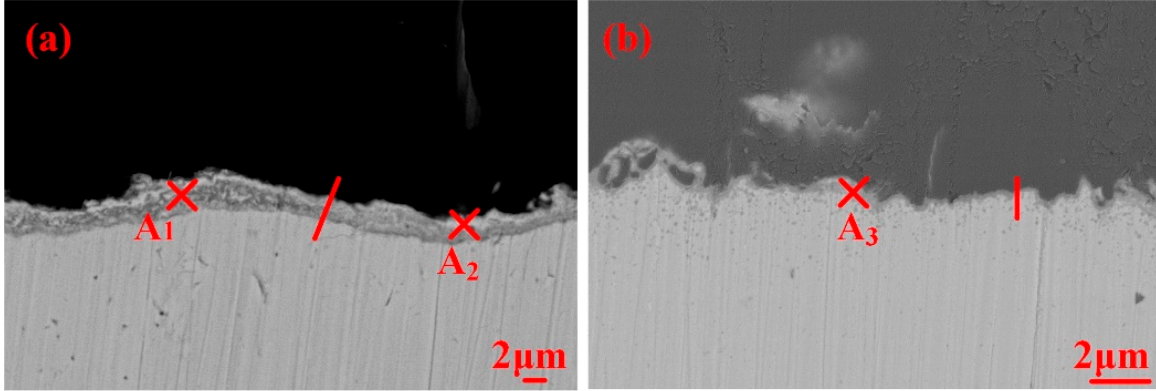
Figure 8. The results of the EDS line-scan in the red line in Figure 7a.